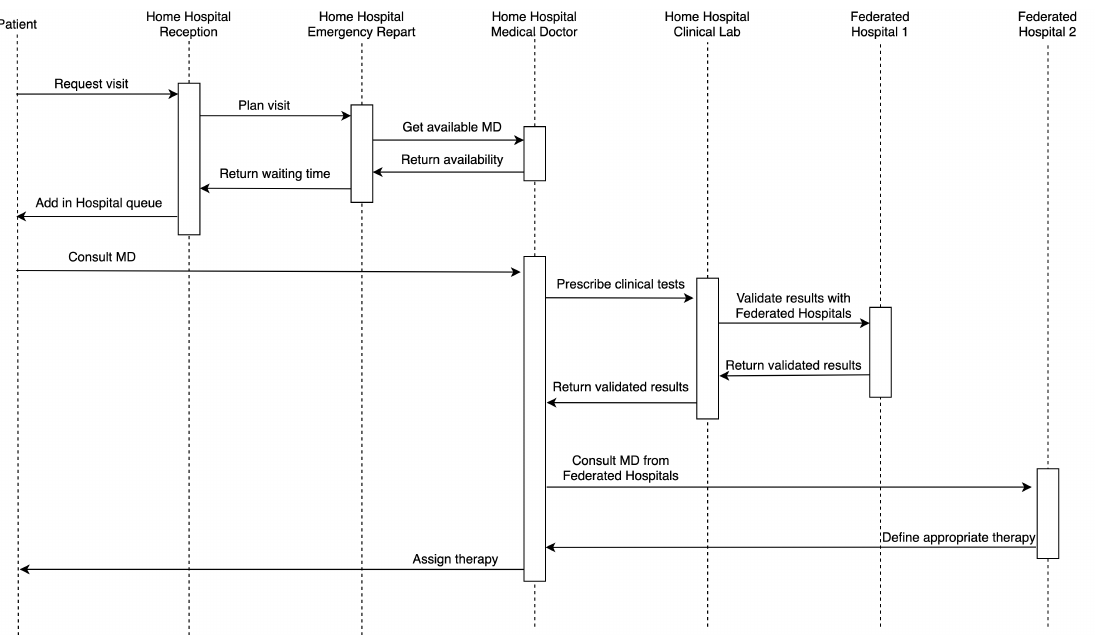
Figure 3. Sequence diagram describing an example of healthcare workflow accomplished in a Federated Cloud hospital environment.